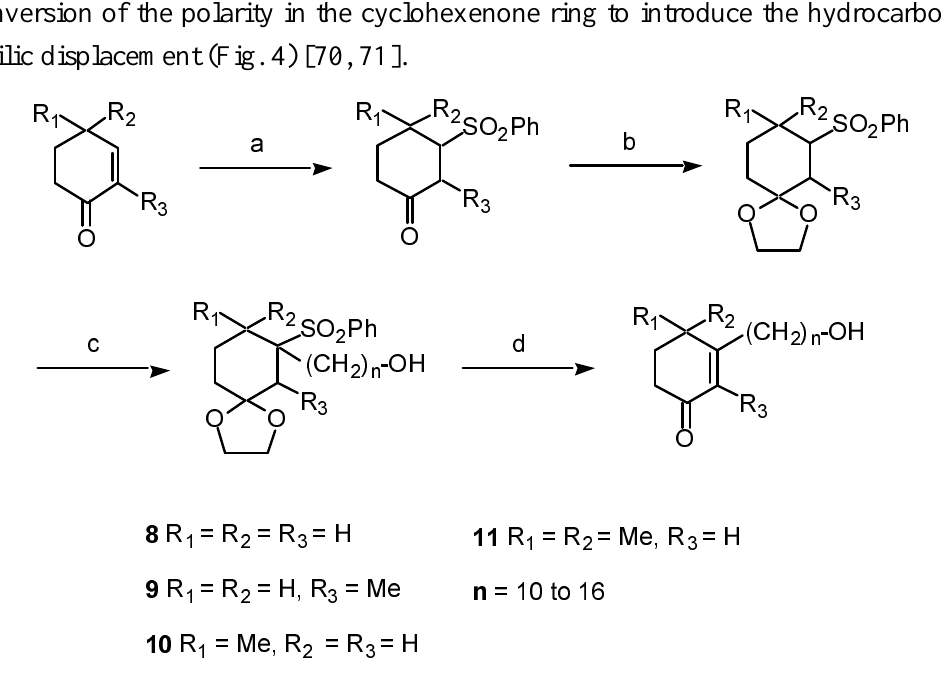
) -OH, pTsOH, 2 n , -78°C to r.t., 1 hour; 3 -acetone (5-1), pTsOH, 50°C, 24 3